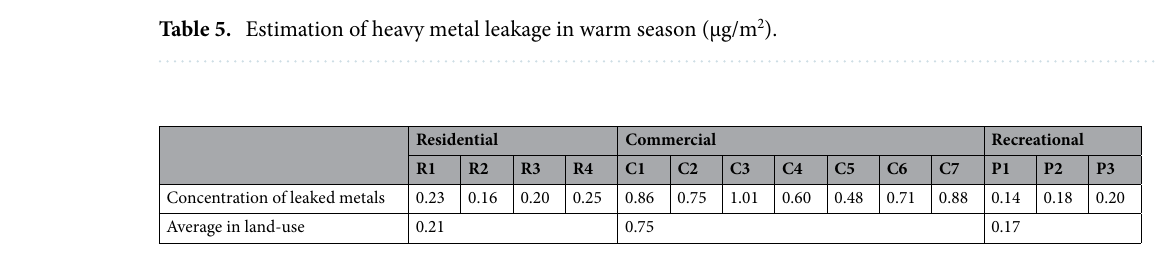
Table 6. Estimation of heavy metal leakage in cold season (μg/m 2 ).